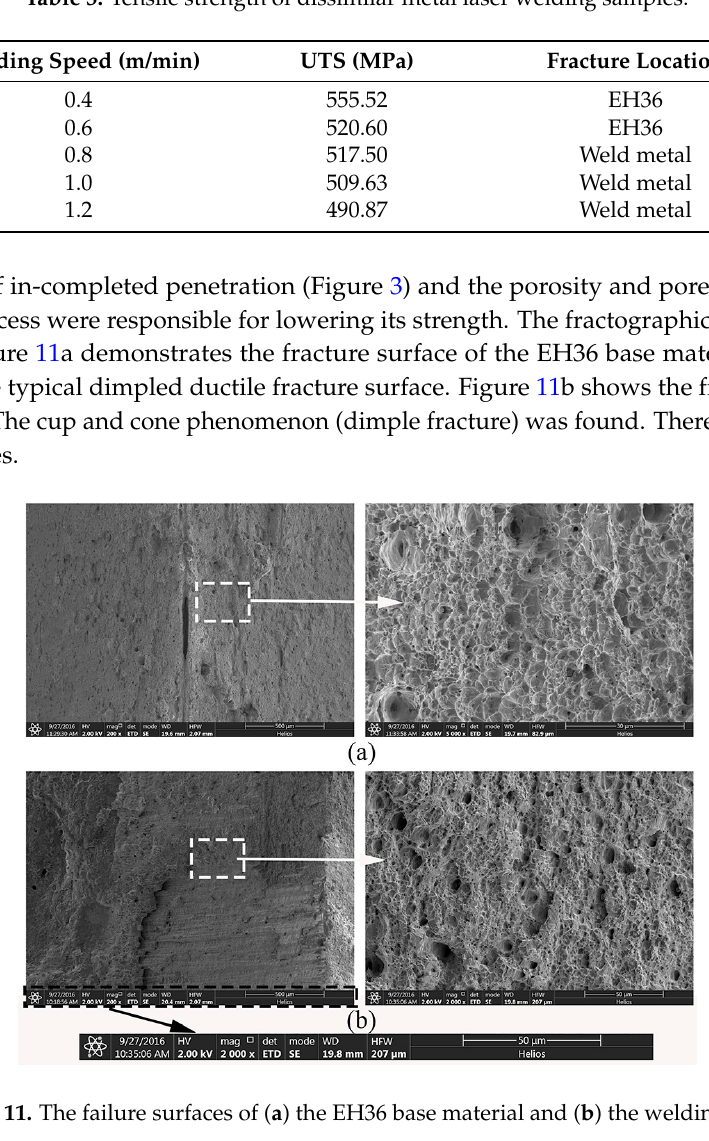
Figure 11. The failure surfaces of ( a ) the EH36 base material and ( b ) the welding joint.